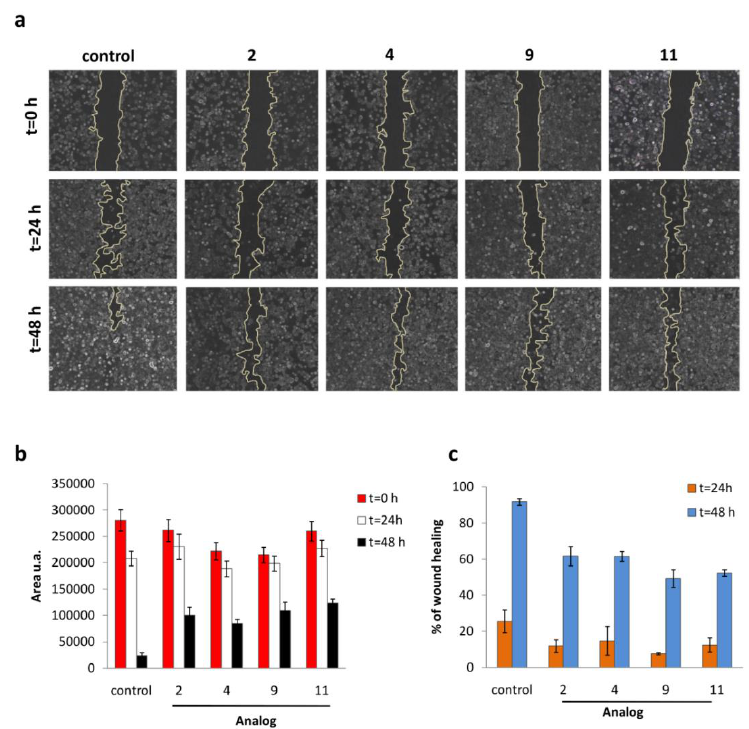
Figure 5. ( a ) Representative images show the scratch (wound) at t = 0, 24 and 48 h with / without drug treatments. Treatment with alkyl-acridones ( 2 and 4 ) and biacridylidenes ( 9 and 11 ) impairs migration of MCF-7 cells. Untreated cells e ffi ciently restore the monolayer after 48 h. ( b ) Quantification of restored surface from three images for each timepoint in the absence / presence of analogs. ( c ) Graph illustrating the % wound healing in MCF-7 cells upon treatment with the compounds after 24 and 48 h. Data represent mean ± standard deviation for three di ff erent